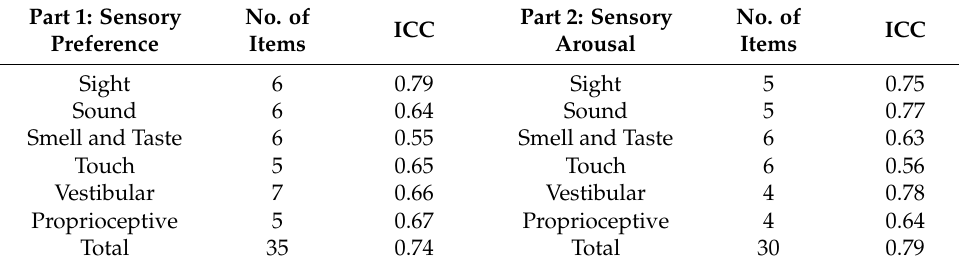
Table 5. Intra-rater reliability and intraclass correlation coefficient of the